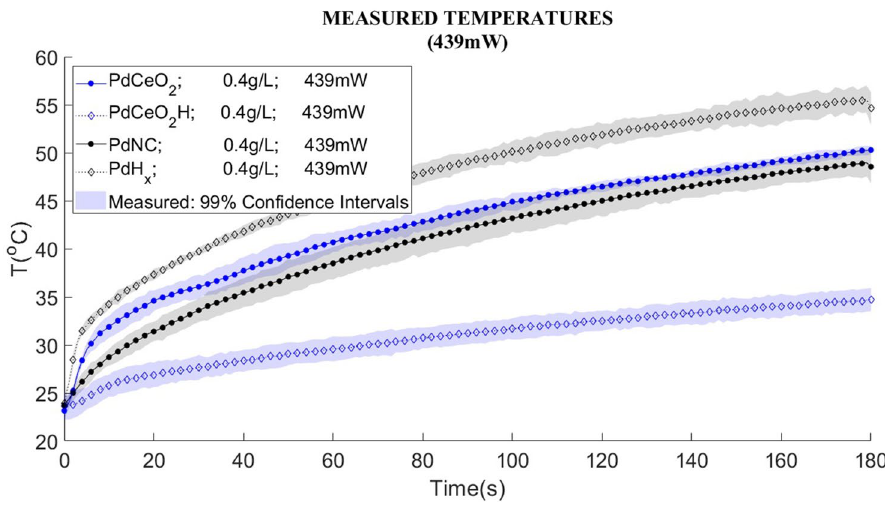
Figure 6. Temperature for palladium and PdCeO 2